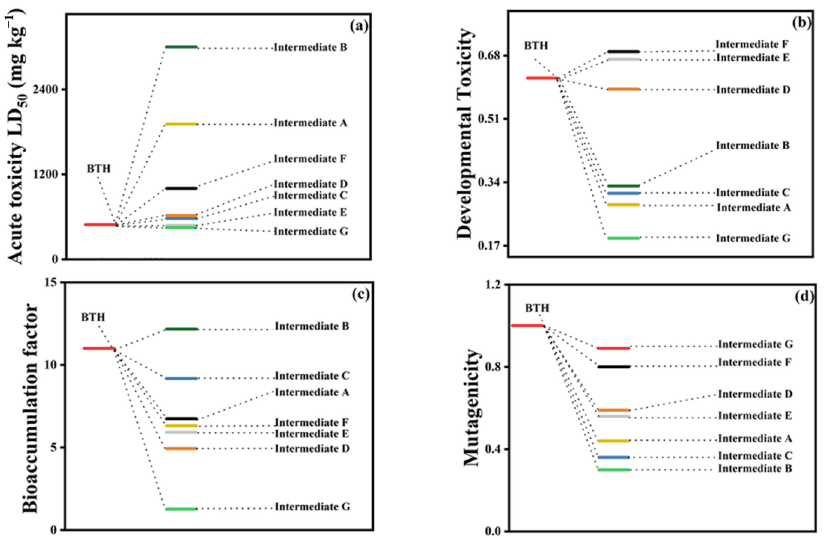
Figure 5. The results of the toxicity calculation of BTH and degradation intermediates in the electron beam irradiation system: ( a ) oral rat LD50; ( b ) developmental toxicity; ( c ) bioaccumulation factor; and ( d ) mutagenicity. Reproduced with permission from [92].